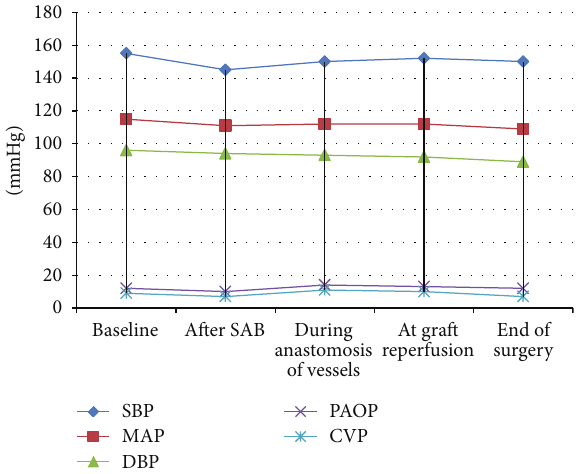
Figure 1: Intraoperative haemodynamics. (Values are mean of readings of eight patients.) SBP: systolic blood pressure, MAP: mean arterial pressure, DBP: diastolic blood pressure, PAOP: pulmonary artery occlusion pressure, CVP: central venous pressure, and SAB: subarachnoid block.